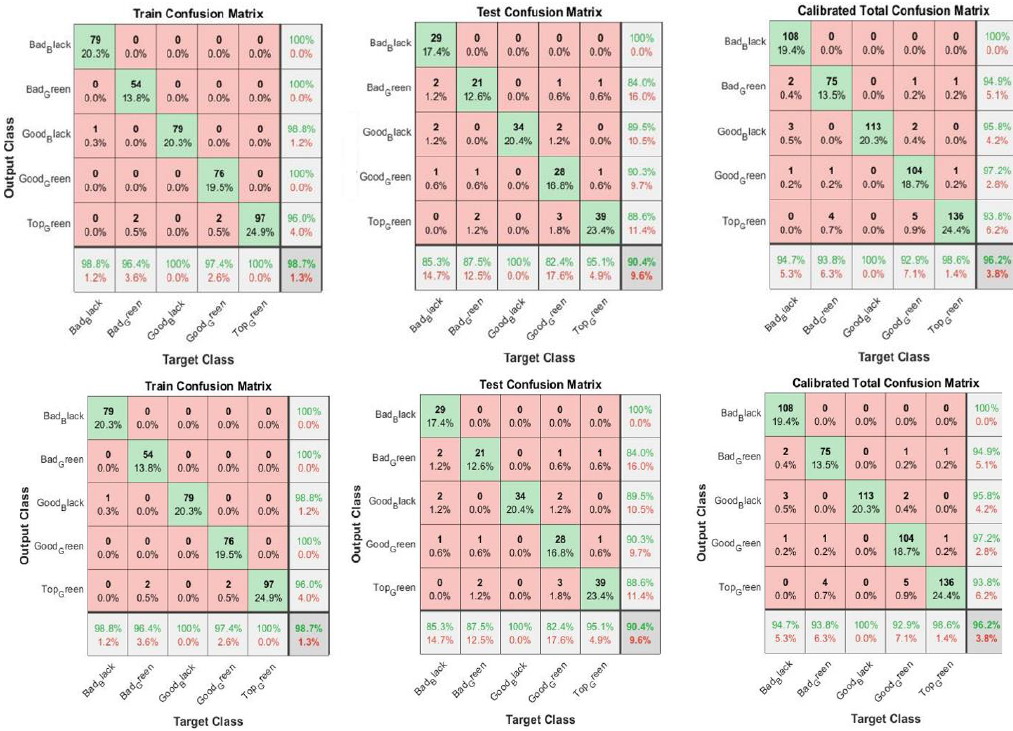
Figure 5. Confusion matrices for training, test and overall calibrated data sets. The off-diagonal elements of these matrices show the number of false positive ( up right ) and false negative ( down left ) cases.